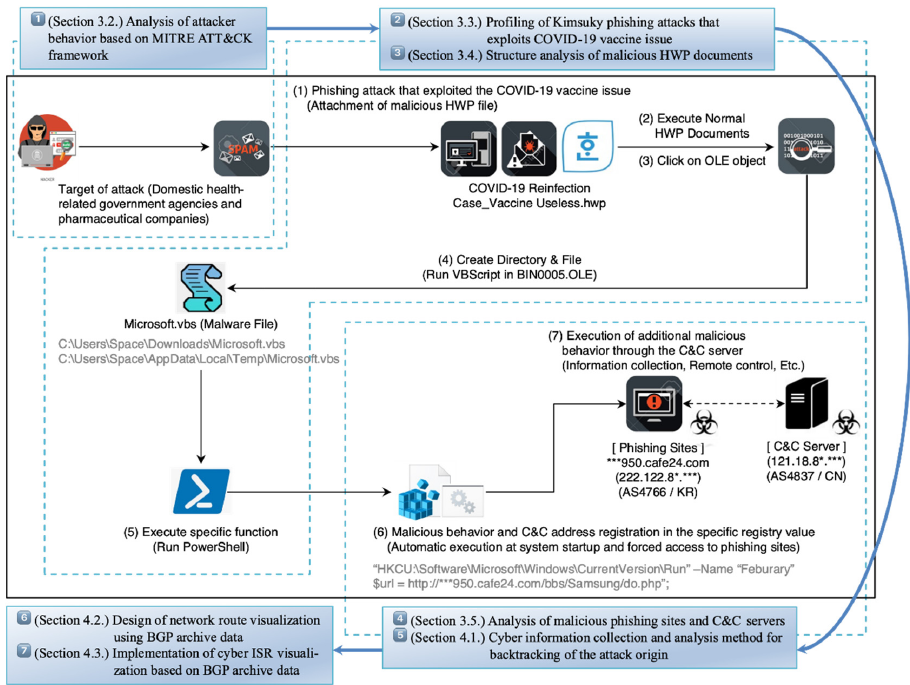
Figure 1. Sequence diagram for profiling Kimsuky’s phishing attack.